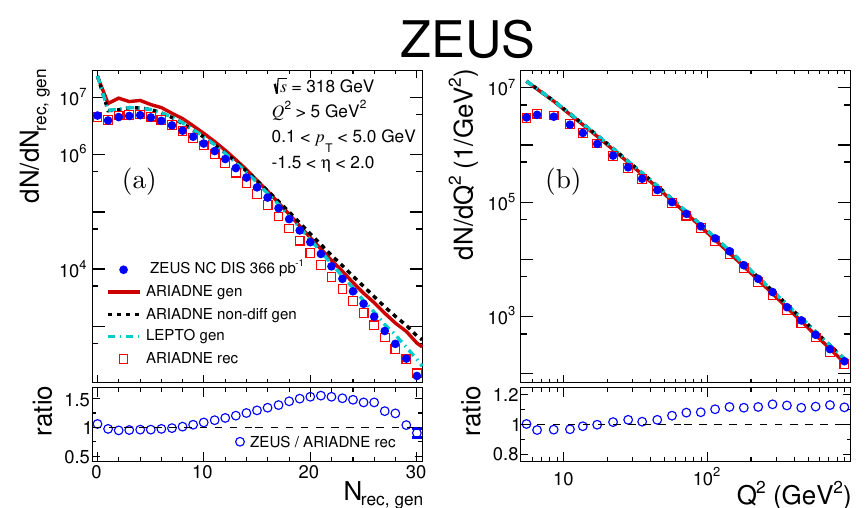
Figure 1 . Reconstructed distributions of (a) multiplicity and (b) Q 2 in data compared to LEPTO and ARIADNE model predictions. The reconstructed Monte Carlo distributions are normalised to the total number of reconstructed events in data. Generator-level distributions are also shown using the same scale factors as for the reconstructed distributions. The normalisation procedure for LEPTO follows that for ARIADNE. The statistical uncertainties are smaller than the marker size.